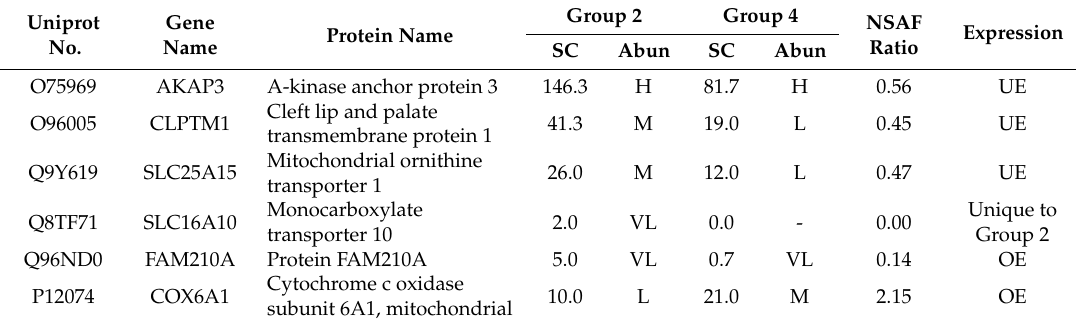
Table 2. Differentially expressed proteins and their abundance in processed semen samples from group 2 ( ≥ 1 × 10 6 /mL leukocytes) and group 4 (round cells < 1 × 10 6 /mL). Uniprot